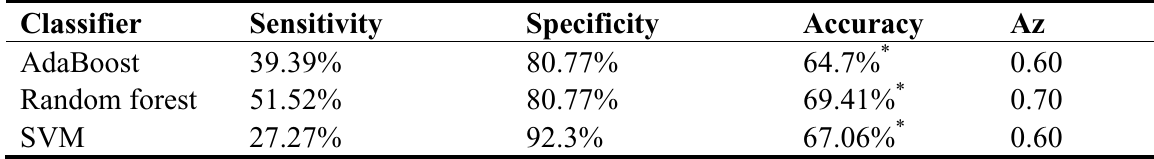
Table 6. Performance comparison among three classifiers with GMM features.